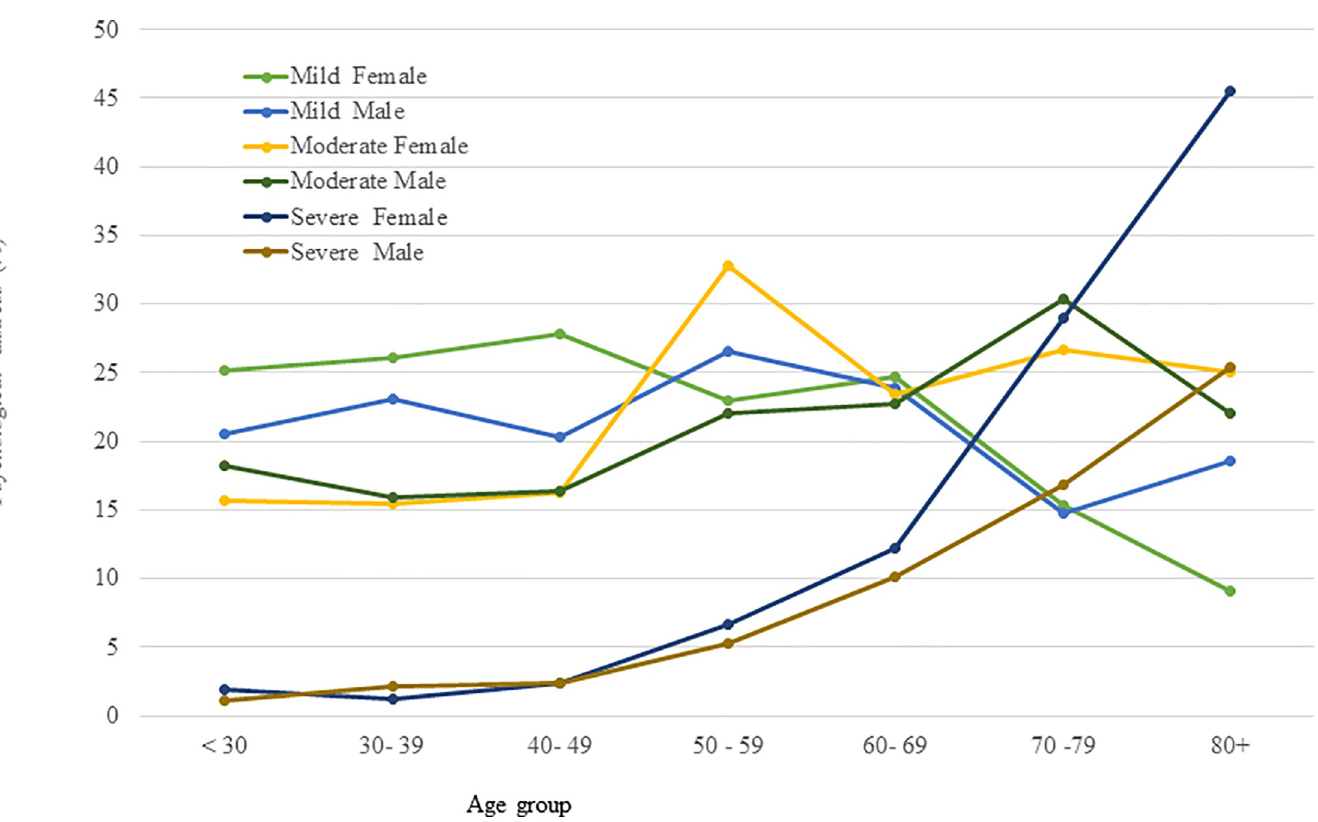
Fig 2. Different levels of psychological distress in males and females by age groups.